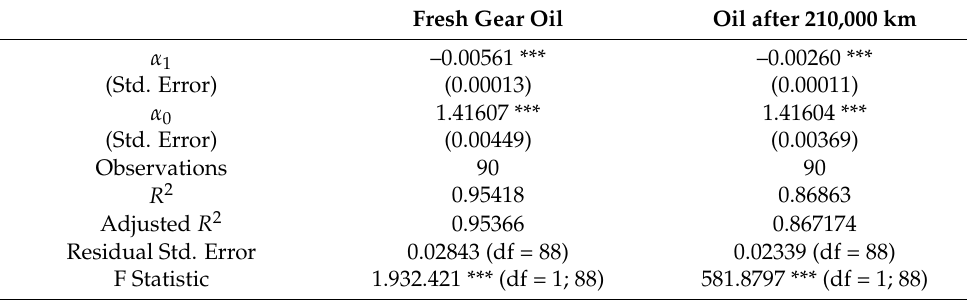
Table 5. Basic parameters of the linear regression model for oil